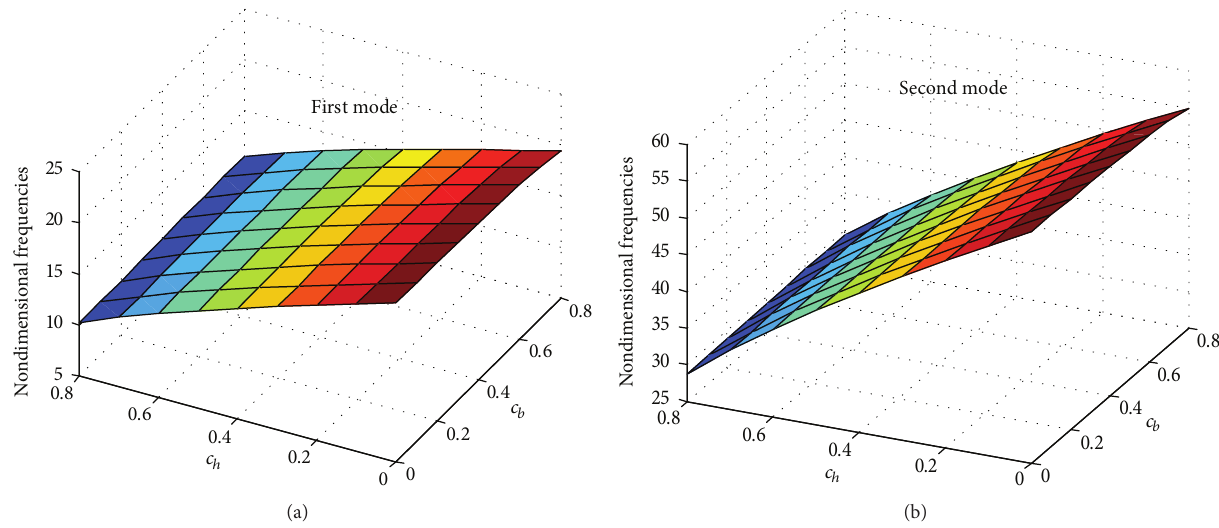
Figure 8: The variation of the first two nondimensional natural frequencies of axially FG beams with respect to taper ratios; boundary condition: